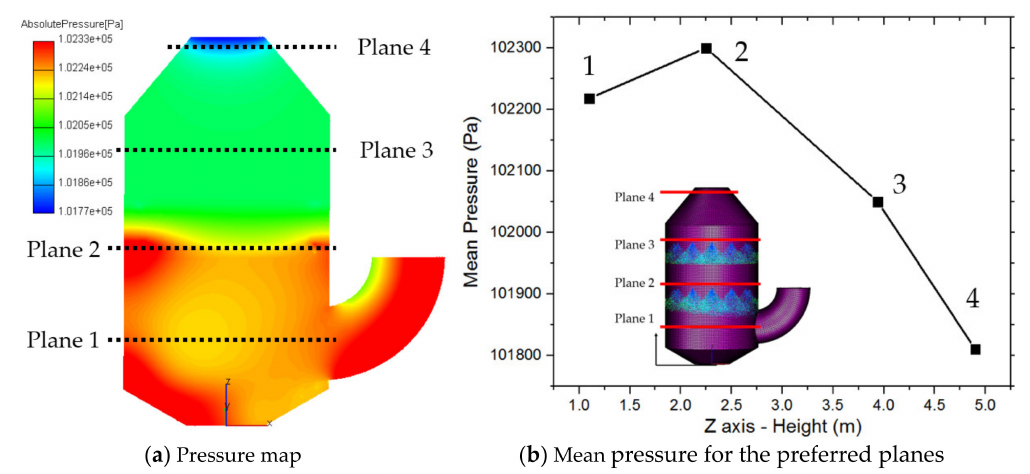
Figure 10. Pressure for the preferred planes along the flow direction.